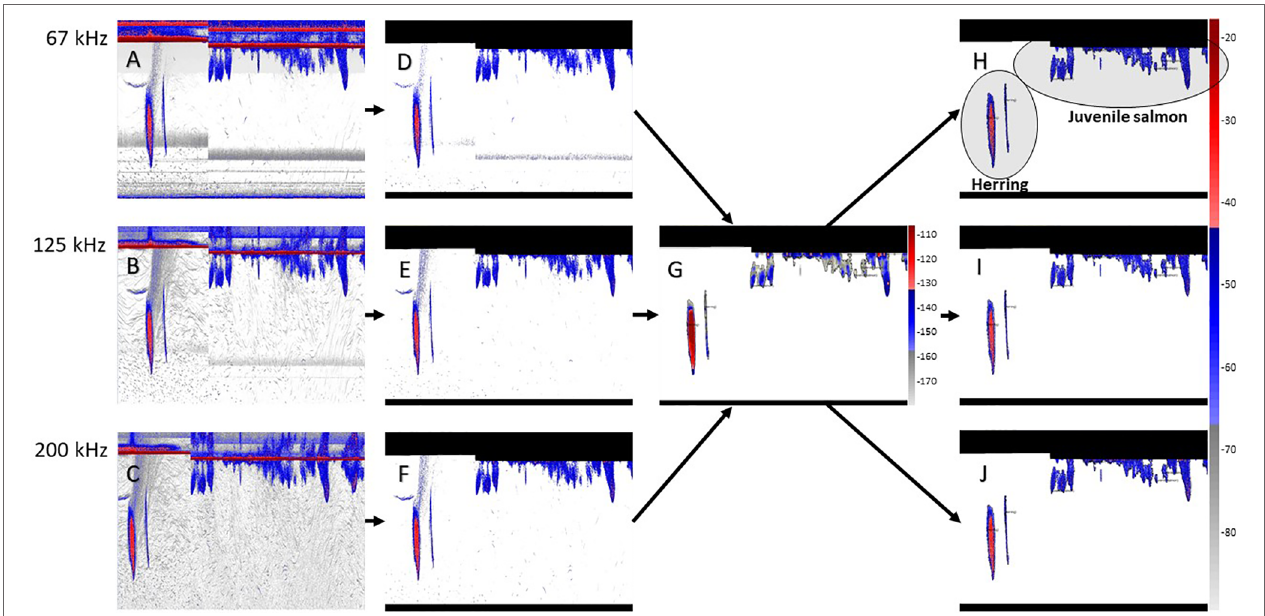
FIGURE 2 | Steps of the acoustic data analysis: raw data at 67, 125 and 200 kHz, respectively (A–C) raw data after background noise has been removed and surface and near-field have been masked (D–F) sum of all three echograms and school detection (G) and school regions applied to echograms (H–J) . The colorbar shows the volume backscattering strength (dB re 1 m). The colorbar on the right-hand side also applies to echograms (A–F) , while echogram (G) shows a different scale. The vertical range represented in the echograms is approximately 50 meters. The echograms cover a period of 20 minutes on May 13 2015 (herring school), and a period of 30 minutes on May 19, 2015 (juvenile salmon